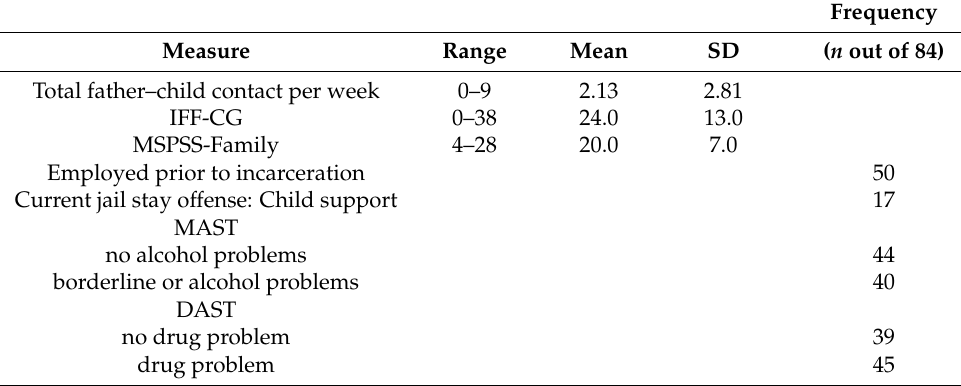
Table 1. Descriptive Statistics for